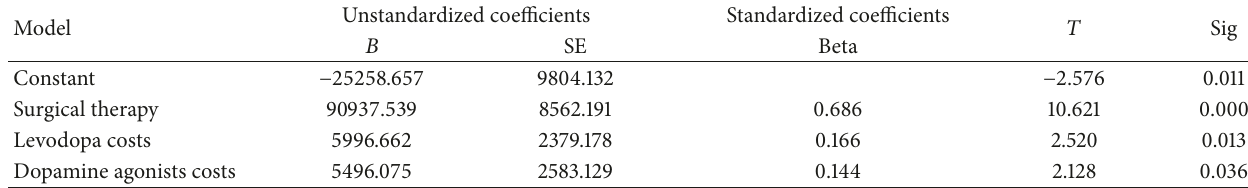
Table 4: Multivariate analyses of the cost-driving